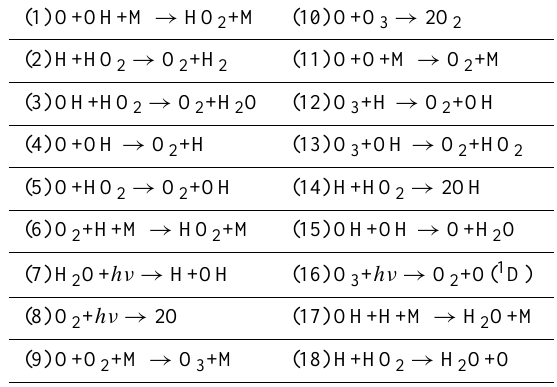
Table 1. List of